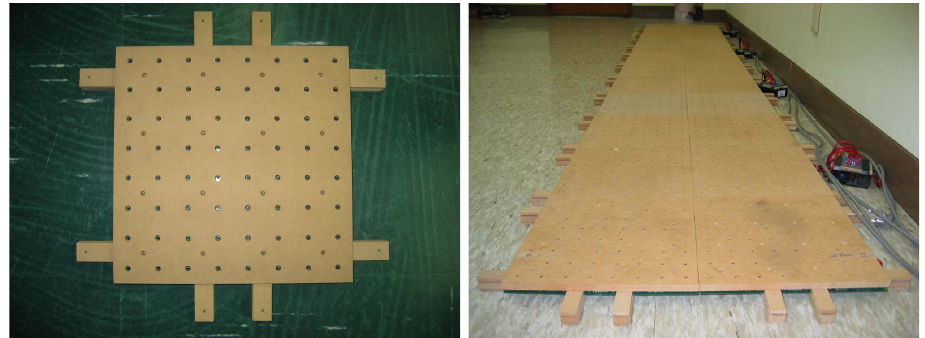
Figure 5. A wooden tile composed of 64 photo interrupters ( left ) and UbiFloorII ( right